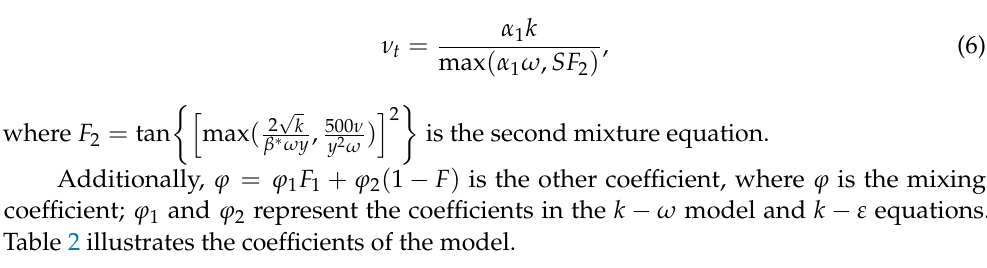
Table 2. Coefficients for turbulence model. α k